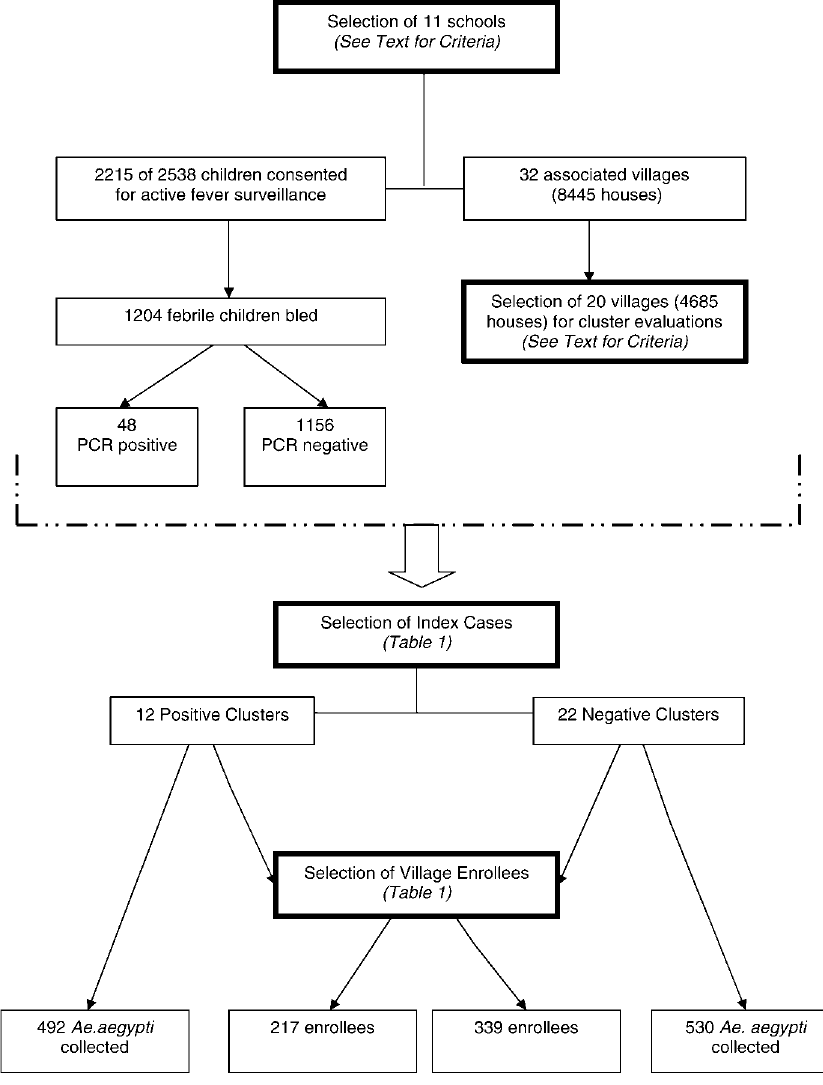
Figure 1. Study Design